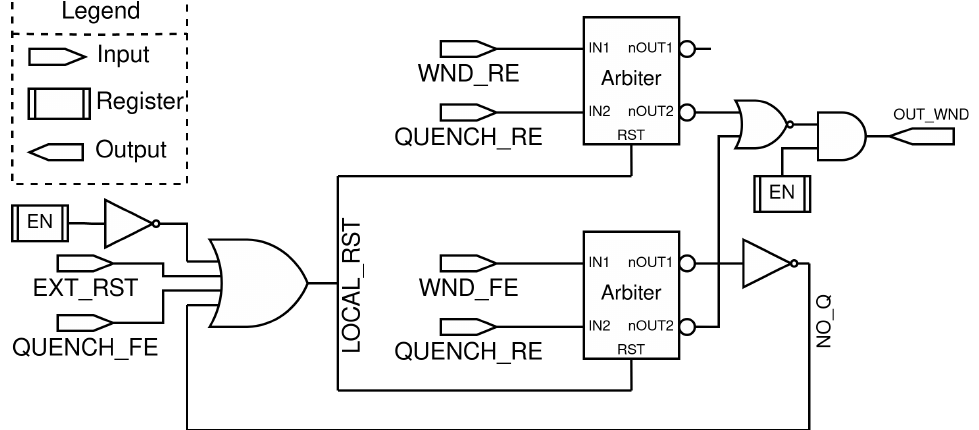
Figure 3. Simplified schematic of the TDC gating circuit that serves to identify three possible situations: (1) the QUENCH_RE is raised inside the window, (2) the QUENCH_RE is raised before